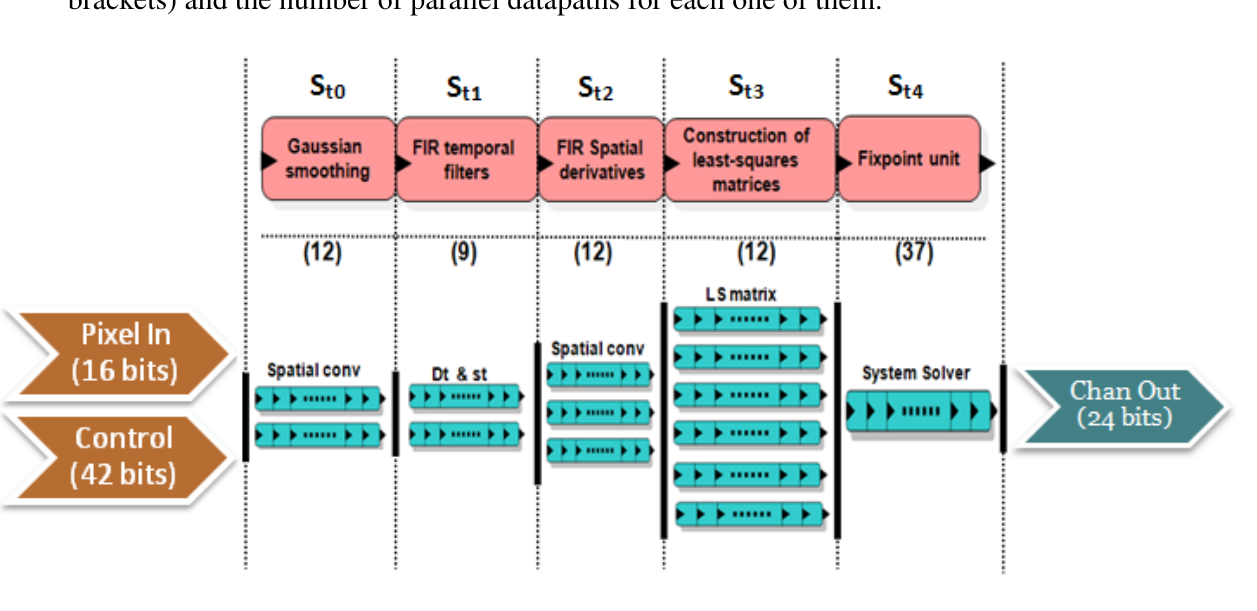
Figure 4. Scheme of the pipelined stages for the Lucas–Kanade vector disparity